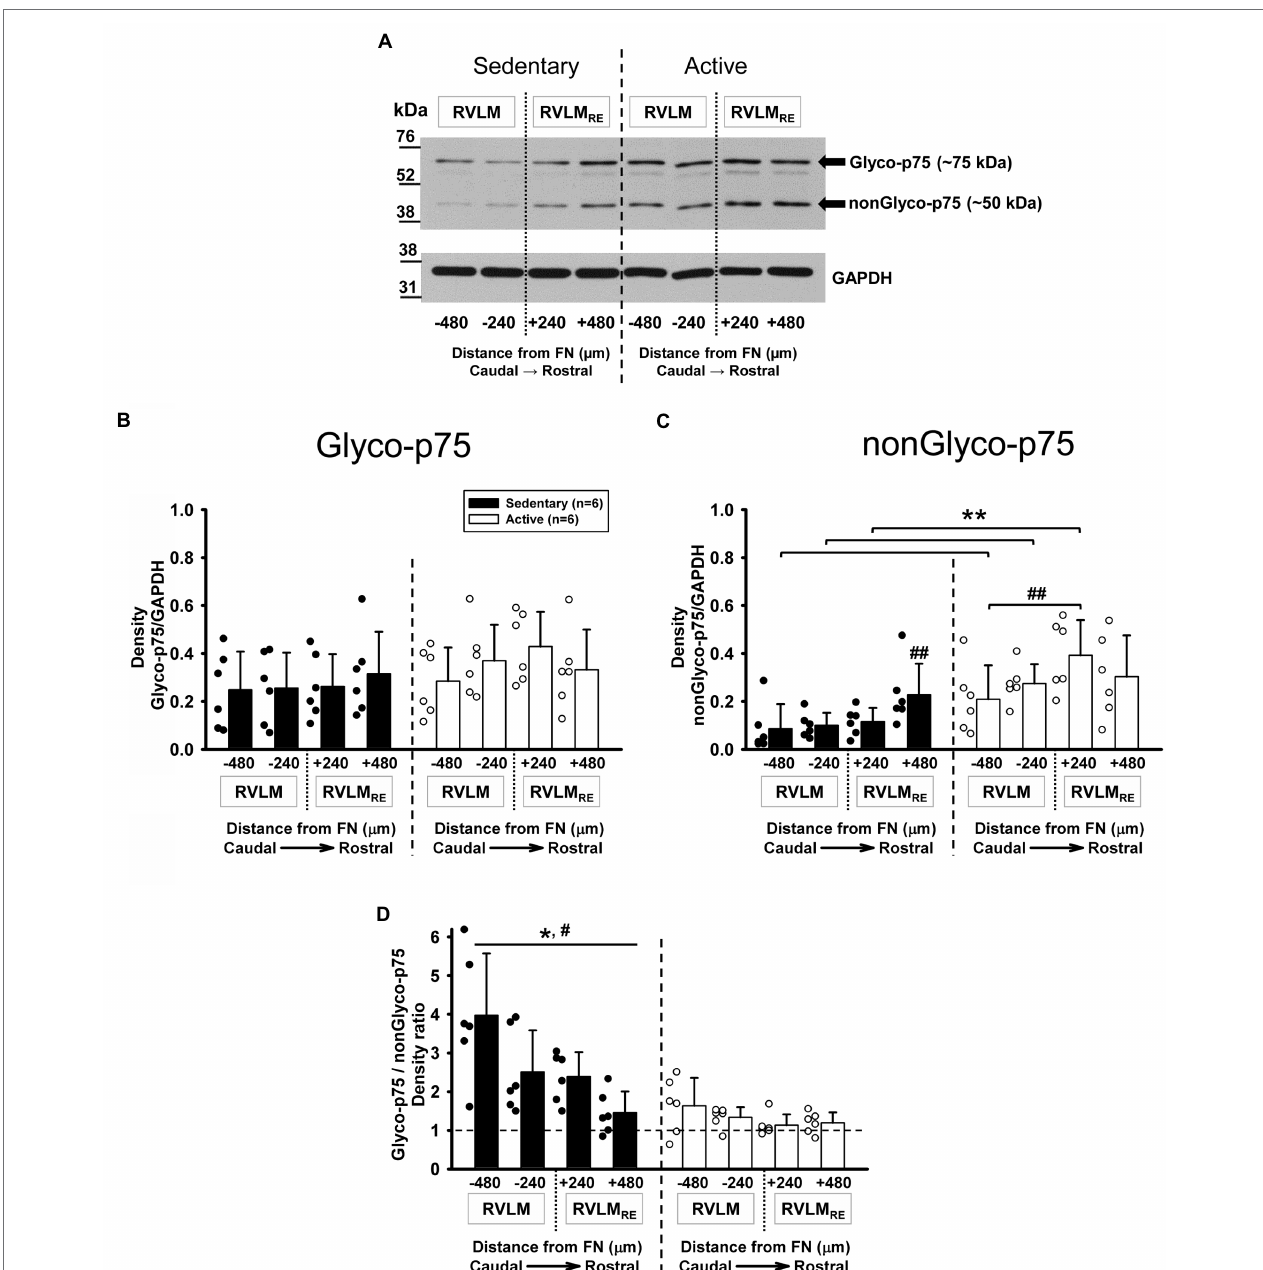
FIGURE 5 | Expression of Glycosylated (Glyco-p75) and non-Glycosylated (nonGlyco-p75) forms of the p75NTR receptor in the RVLM/RVLM RE following 12 weeks of sedentary vs. physically active conditions. (A) Representative Western blot of Glyco-p75 (arrow ~75 kDa), nonGlyco-p75 (arrow ~50 kDa), and GAPDH expression at different rostrocaudal levels of the RVLM and the RVLM RE . (B) Group data from sedentary (black bars) vs. physically active (white bars) conditions ( n = 6 ea) demonstrate no significant overall difference in the expression of Glyco-p75 in sedentary compared to active animals [ F (1, 30) = 1.150, p = 0.309, main effect of group] and there was also no overall significant effect of rostrocaudal distribution [ F (3,30) = 1.877, p = 0.155; main effect]. The interaction between experimental groups and rostrocaudal levels did not reach a significance [ F (3,30) = 2.029, p = 0.131], which precluded further post hoc testing. (C) Group data from sedentary vs. physically active conditions demonstrate a significant interaction term [ F (3,30) = 3.384, p = 0.031] and revealed a significantly lower expression of nonGlyco-p75 in both RVLM subregions (** p = 0.004 for FN-480 and p = 0.006 for FN-240) and in the FN + 240 subregion of the RVLM RE (**, p = 0.001) of sedentary rats. Sedentary rats showed significantly higher expression of nonGlyco-p75 in the FN + 480 of the RVLM RE compared to the FN + 240 (##, p = 0.012) and both RVLM subregions (##, p = 0.004 for FN-240 and p < 0.001 for FN-480). Physically active rats exhibited significantly higher expression of nonGlyco-p75 in the FN + 240 subregion of RVLM RE compared with the FN-480 of RVLM (##, p = 0.006). See Supplementary Table S3 for results of all rostrocaudal comparisons within groups. (D) Group data showing that the Glyco-p75/nonGlyco-p75 ratio was overall significantly higher in sedentary rats vs. physically active [*, F (1,30) = 20.829, p = 0.001, main effect] and that there was